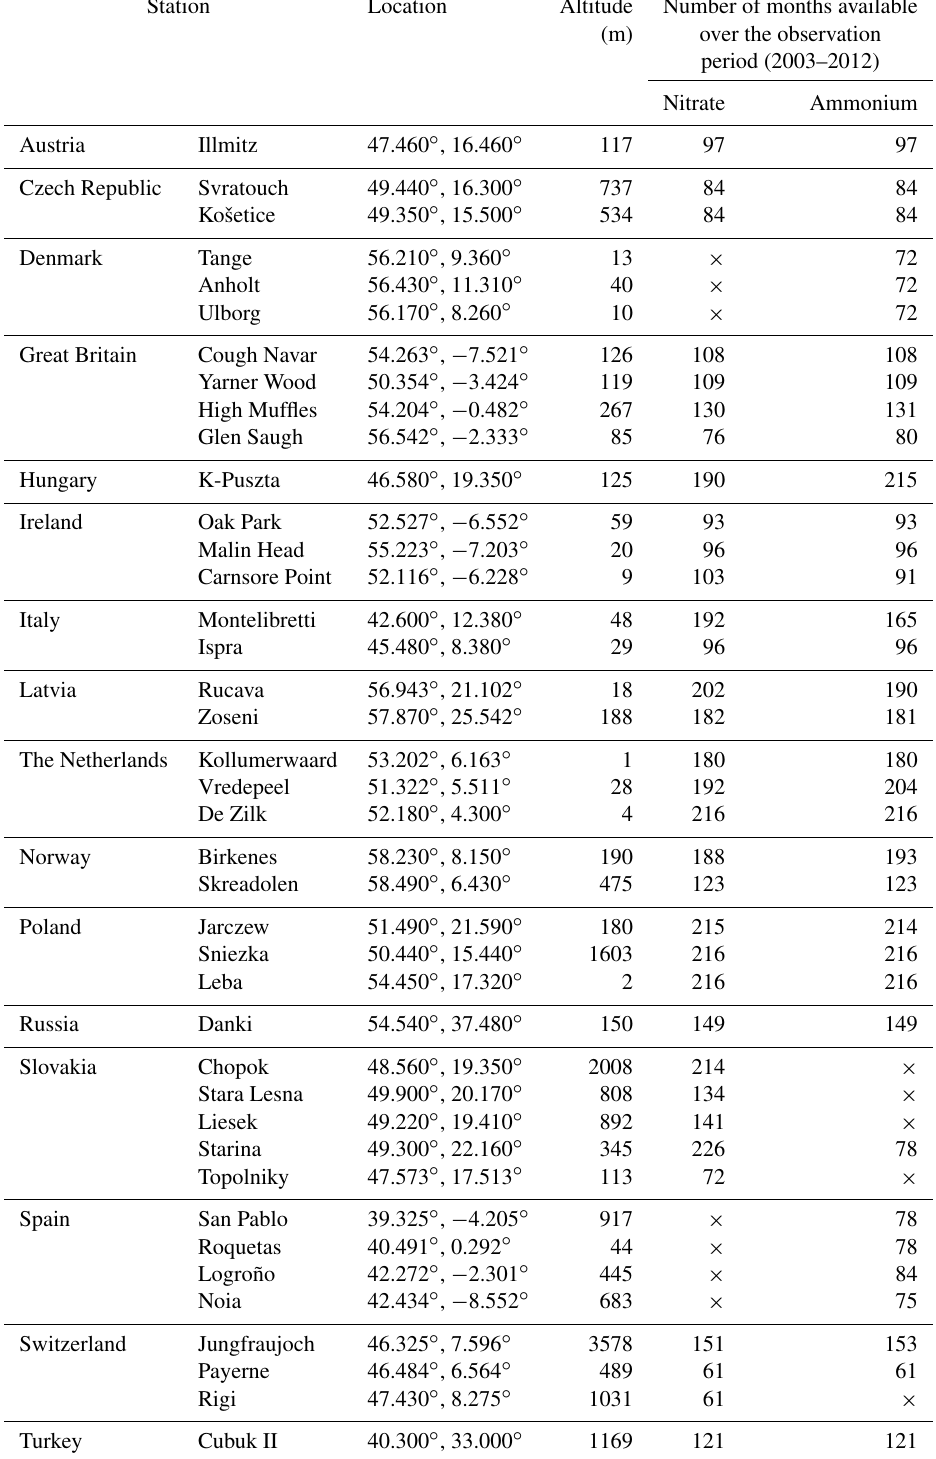
Table 2. Station name, location, altitude and number of months available over the observation period (1994–2014) of the 40 EMEP